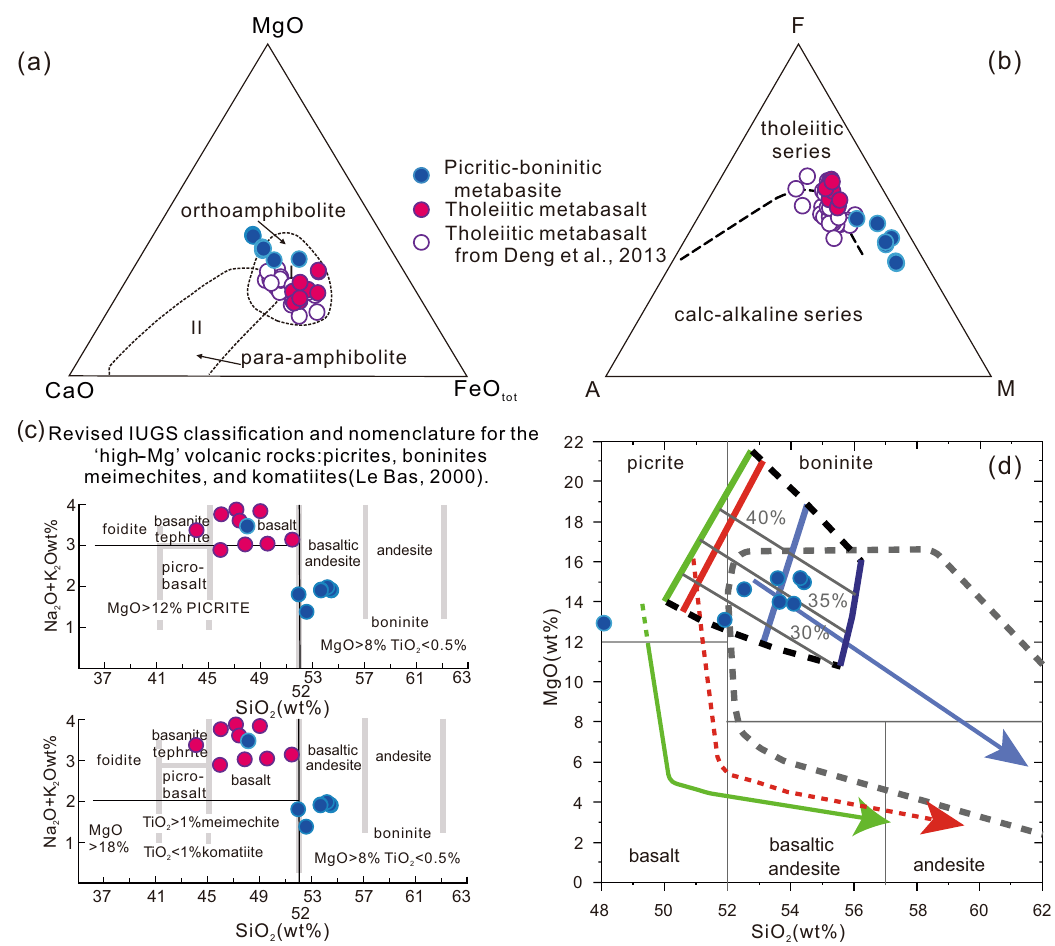
Fig. 6 Discrimination diagrams constraining protolith of the metabasite. a MgO-CaO-FeO tot 31 is for the amphibolites, with domain I referring to ortho- amphibolite and domain II to para-amphibolite. Our data is in blue for the picrite-boninite series, red for the tholeiites, plotted with data from other Zanhuang basalts (open circles) from Deng et al. 26 ; b AFM diagram 35 showing that the metabasalts plot along the tholeiitic trend; c SiO 2 vs. alkalis classi fi cation scheme and nomenclature 33 for high-Mg volcanic rocks including picrite, basalt, and tholeiite, with the Zanhuang samples plotting in the fi elds of basalt (for the tholeiites) and near the boundary of the picrite-boninite fi elds; d SiO 34 with our primitive samples plotting in the 2 vs. MgO plot picrite-boninite series. Dark gray contour outlines fi eld of Izu-Bonin bonitites. Thick colored lines represent the compositional range of melts modeled by Bénard et al. 34 from samples of the hybrid mantle wedges of the Kamchatka and Bismark forearcs, whereas the green, red, and blue lines with arrows represent modeled liquid lines of descent 34 from picritic and boninitic parental melts, and the gray lines indicate the melting